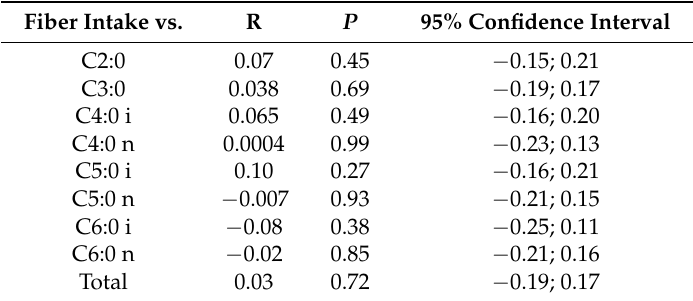
Table 5. The correlation between fiber intake and SCFAs